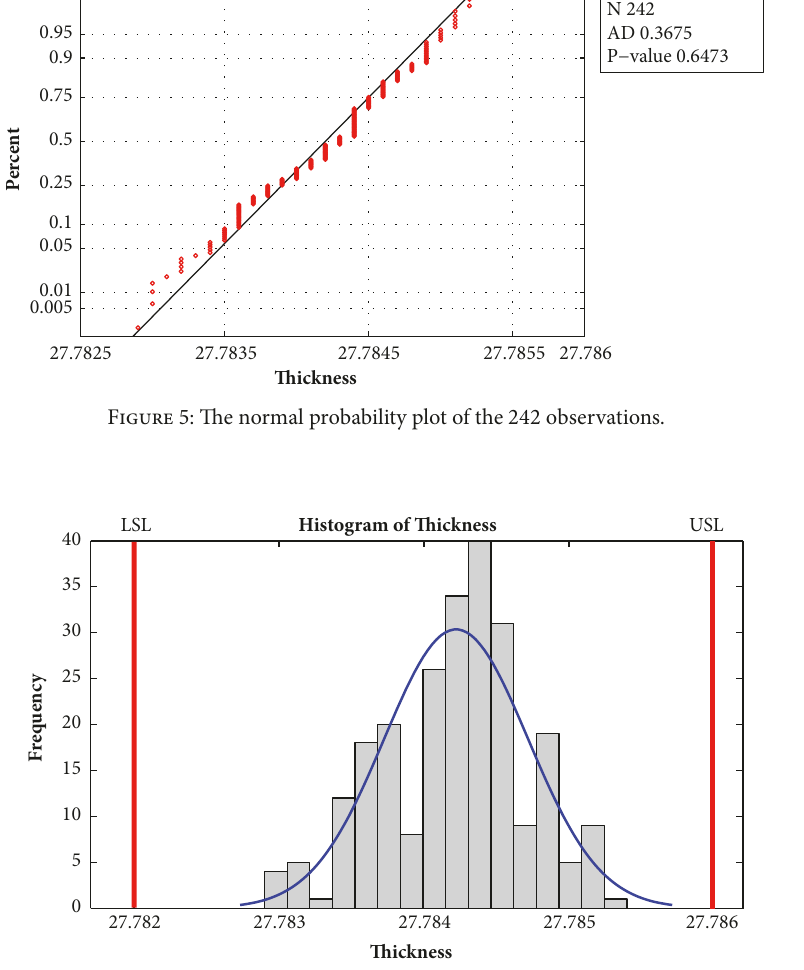
Figure 6: The histogram of the 242 observations with double specification limits.